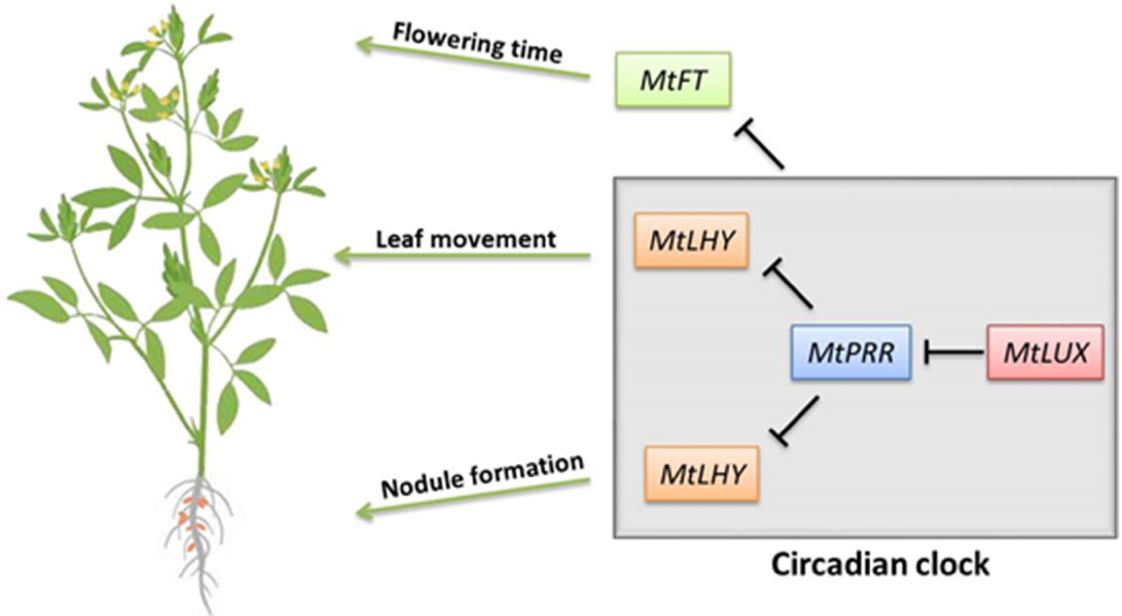
Figure 6. Model for the proposed role of MtLUX in M. truncatula . MtLUX is responsible for the down ‐ regulation of MtPRRs and the up ‐ regulation of MtLHY . The MtLUX ‐ associated circadian clock is involved in the regulation of nodule formation, leaf movement, and flowering time.